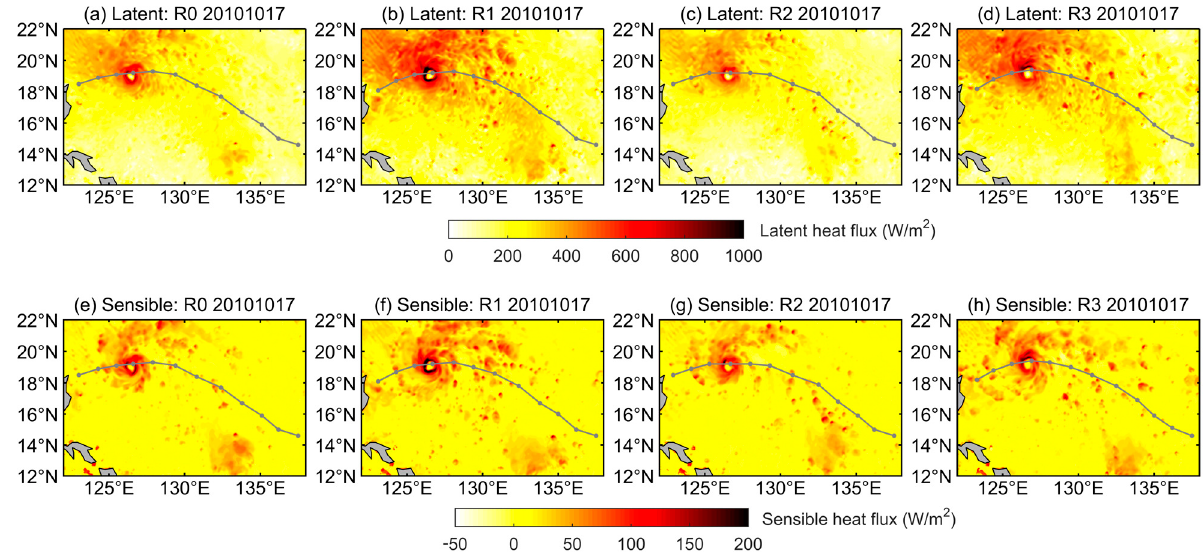
Figure 15. Distributions of heat fluxes for Megi. ( a – d ) Distributions of modeled latent heat fluxes for 17 October 2010 in R0, R1, R2, and R3; ( e – h ) distributions of modeled sensible heat fluxes for 17 October 2010 in R0, R1, R2, and R3. Grey lines are the simulated tracks for Megi. See Section 3.1 for details of the simulations.